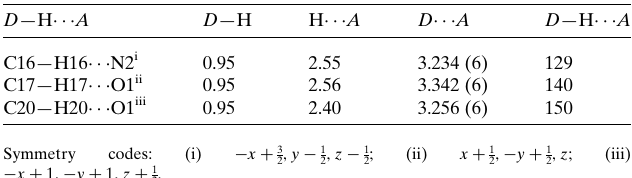
Table 1 Hydrogen-bond geometry (A˚ , (cid:3)